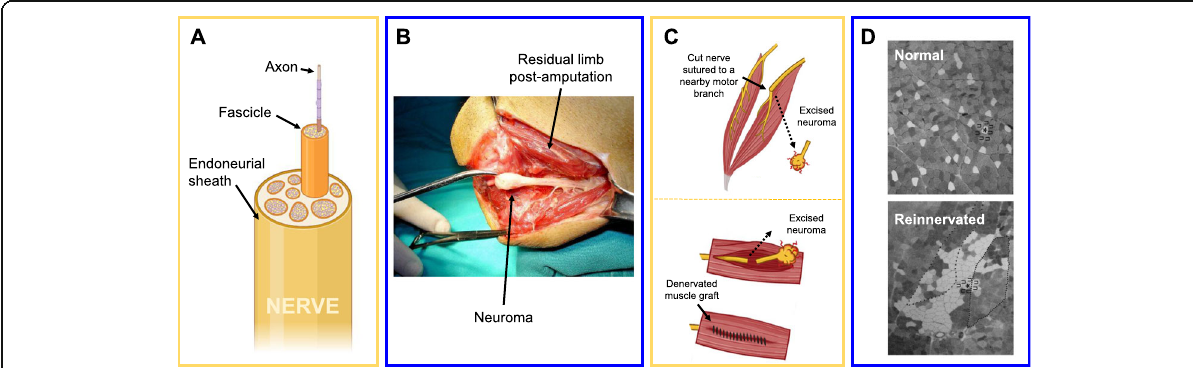
Fig. 2 Regenerating Nervous System. a The cross-section of a nerve contains bundles of axonal projections traveling away from their cell bodies. The entire nerve is wrapped in an endothelial tissue referred to as the endoneurial sheath. Within the endoneurium, axons are grouped into fascicles that later branch out of the nerve. b A neuroma is a mix of fibroblasts, collagen, scar tissue, and neuron axons that have escaped from a cut nerve. This tissue is electroactive and known to cause severe pain in amputees (ehirlio lu et al., 2007). c To prevent neuromas from forming, a cut nerve ending can be sutured to the distal motor branch of a nearby nerve (a.k.a. nerve-nerve coaptation or TMR, shown on top). Another option for preventing pain is to wrap a denervated muscle graft around the cut nerve ending (shown on bottom). Both devascularized grafts (RPNIs) and vascularized grafts (VDMTs) have been demonstrated to prevent neuroma formation in humans. d Reinnervated muscle shows some very obvious and reproducible differences when compared to intact muscle. The most visually obvious change is the loss of a mosaic distribution among fibers from one MU. Instead of a mosaic, reinnervated muscle develops MUs in which all of the fibers in that unit are spatially clumped up together. Different shades of grey in this image of a muscle cross-section represent different fiber types, and darker fibers have higher oxidative capacity (less fatigability) (Brooke et al.,